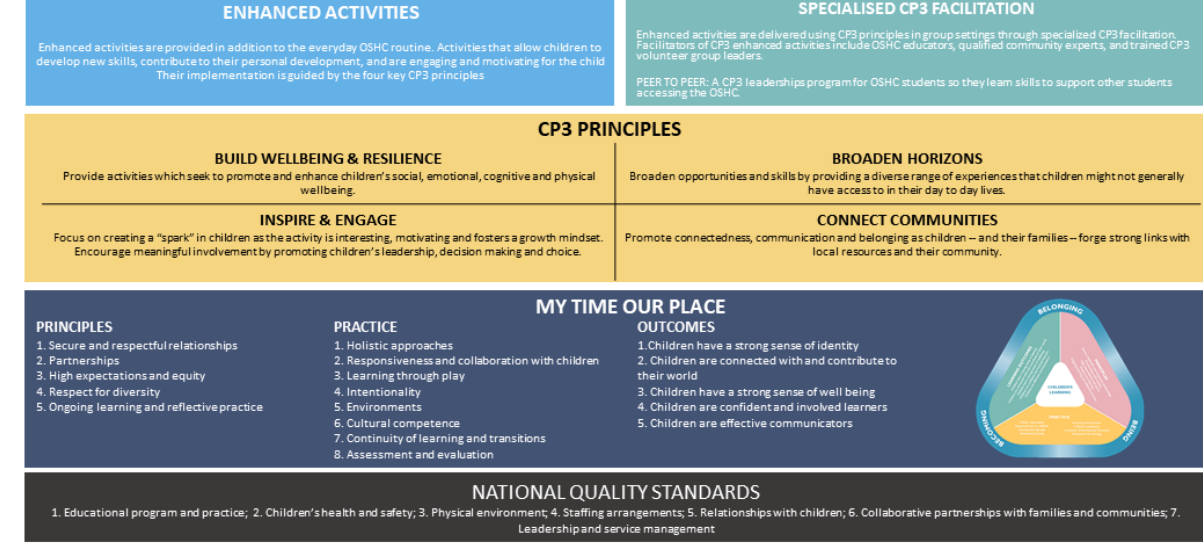
Figure 6. Connect, promote, and protect program model underpinned by the existing My Time Our Place Framework and the National Quality Standards. CP3: connect, promote, and protect